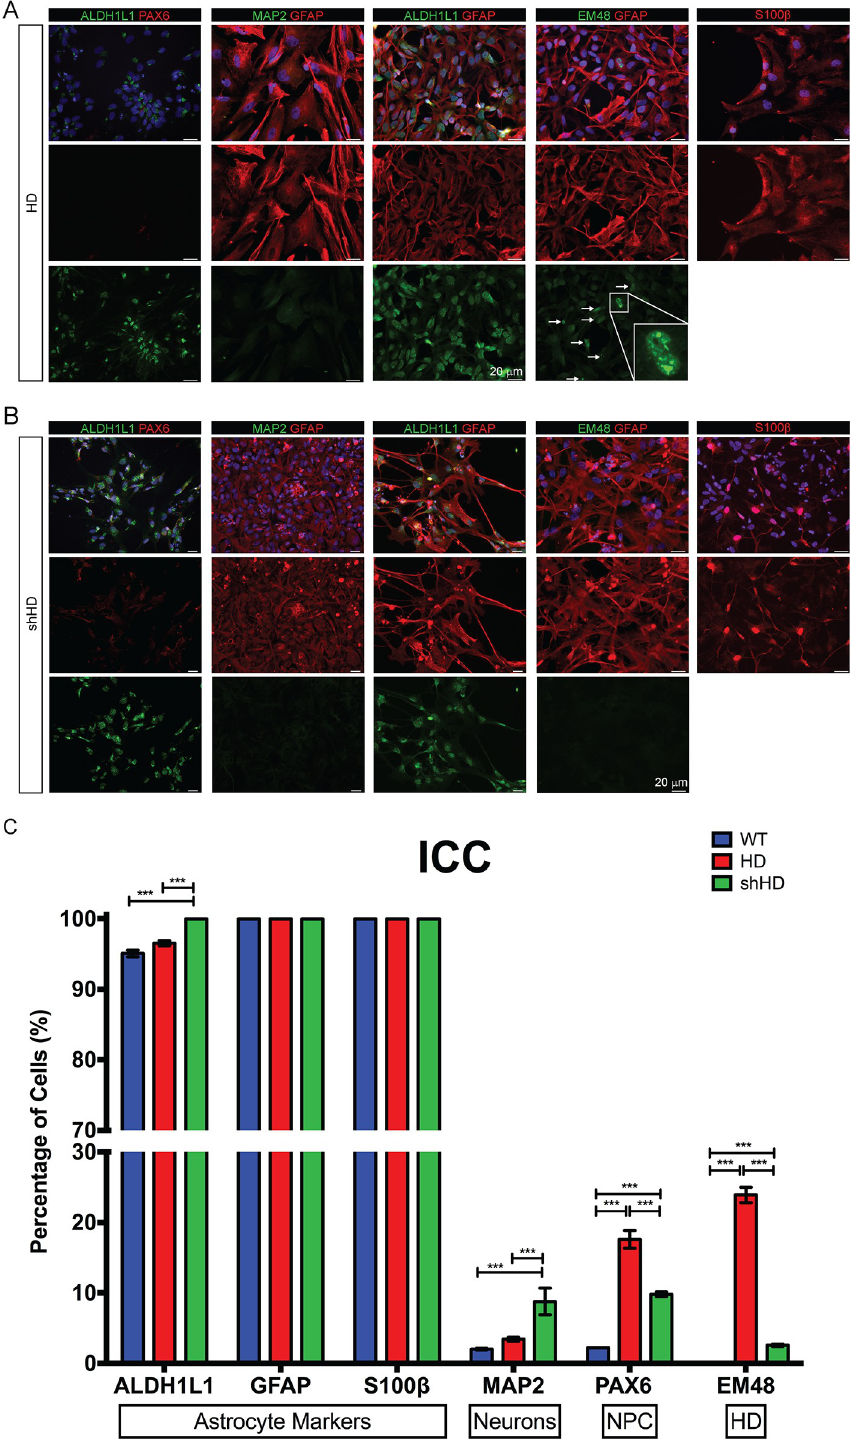
Fig 2. Differentiation of HD-NPC and shHD-NPC into astrocytes. (A) Astrocytes differentiated from HD-NPC expressing canonical astrocyte-specific markers, GFAP, ALDH1L1, and S100 β . Staining with mEM48 showed nuclear and cytoplasmic aggregates of mHTT. (B) Astrocytes differentiated from shHD-NPC expressing canonical astrocyte- specific markers: GFAP, ALDH1L1, and S100 β . Staining with mEM48 showed a lower number of cells that are positive for mEM48. (C) Quantification of ICC results showing all three cell lines expressed high percentage of cells with